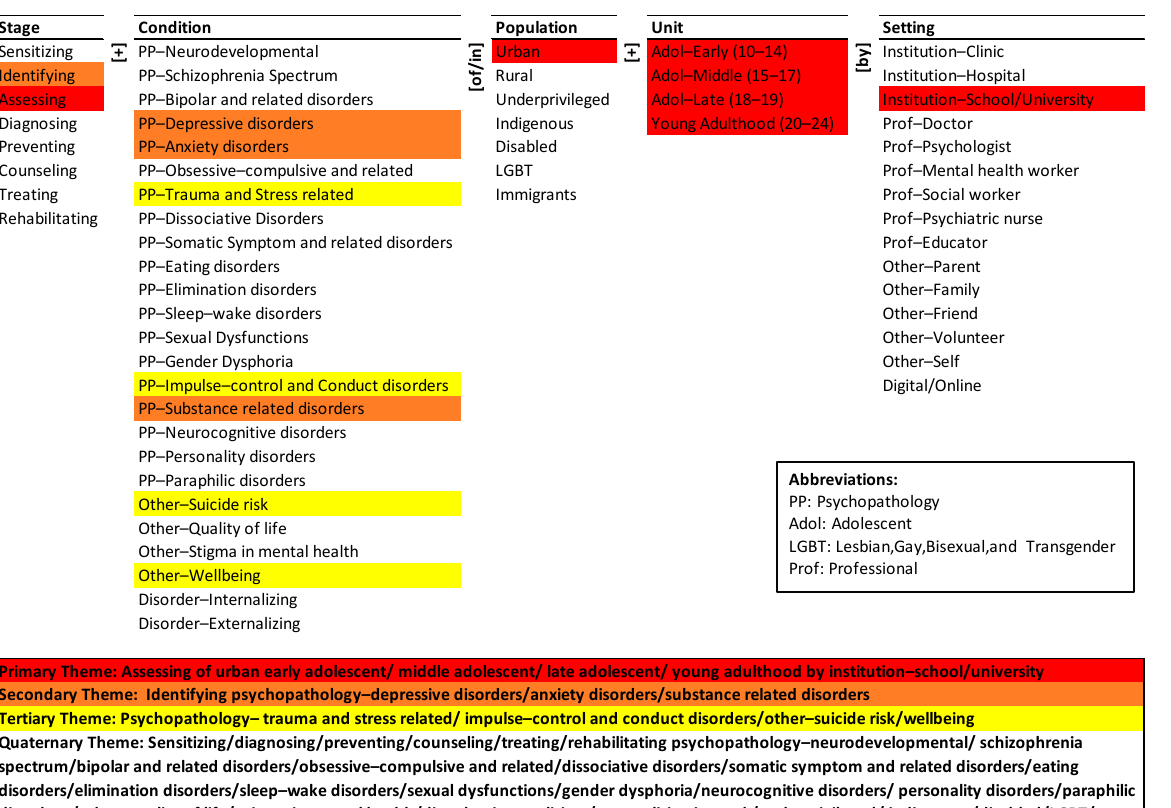
Figure 4. Theme map of mental health of adolescents and youth in Chile.